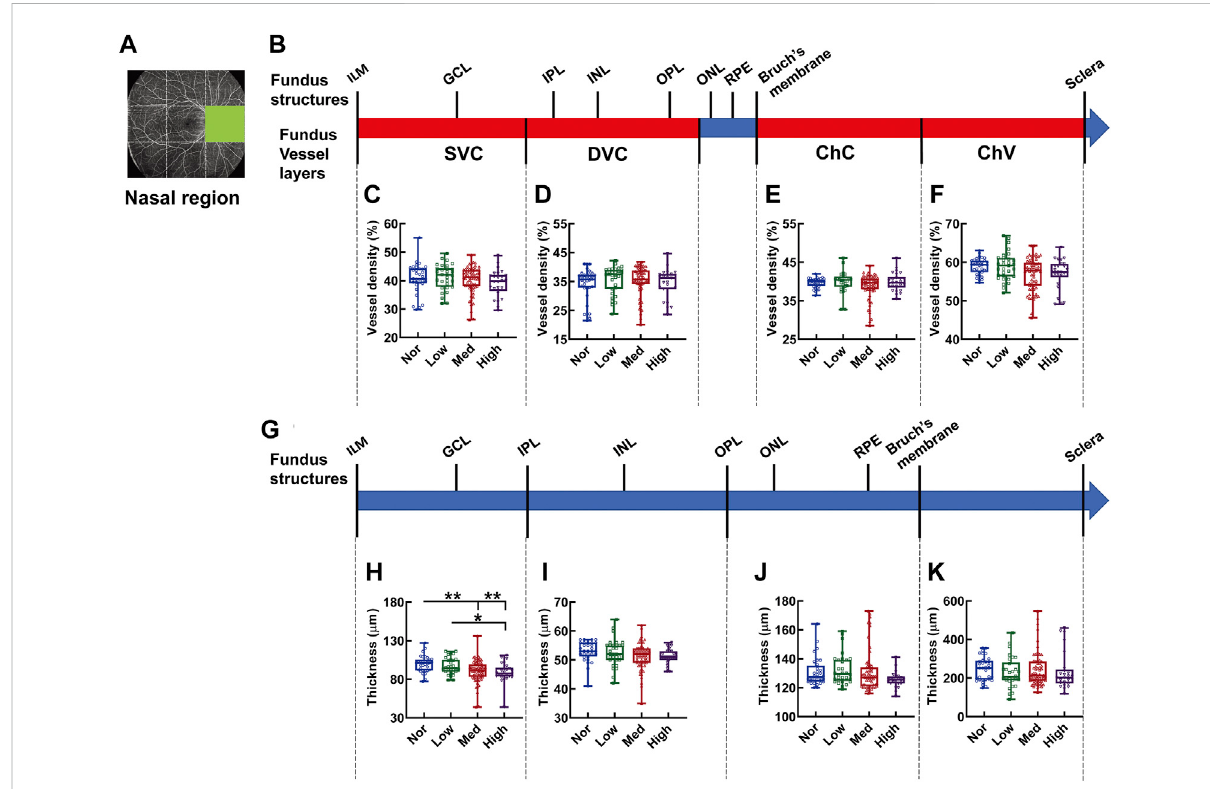
FIGURE 8 Vessel layer densities and structure thicknesses at the nasal region of the fundus. Position of the nasal region of the fundus is illustrated in (A) . Schematic illustration of vessel layers in the fundus is shown in (B) . Vessel densities of super fi cial vascular complex (C) , deep vascular complex (D) , choriocapillary (E) , and choroidal vessel (F) layers are quanti fi ed and compared. Schematic illustration of segments in the fundus is shown in (G) . Thicknesses of the segments from IML to IPL (H) , from IPL to OPL (I) , from OPL to Bruch ’ s membrane (J) , and from Bruch ’ s membrane to the sclera (K) are quanti fi ed and compared. * p < 0.05, ** p < 0.01. SVC, super fi cial vascular complex; DVC, deep vascular complex; ChC, choriocapillary layer; ChV, choroidal vessel layer; NOR, normal group; Low, low-myopia group; Med, medium-myopia group; High, high myopia group; IML, inner limiting membrane; IPL, inner plexiform layer; and OPL, outer plexiform